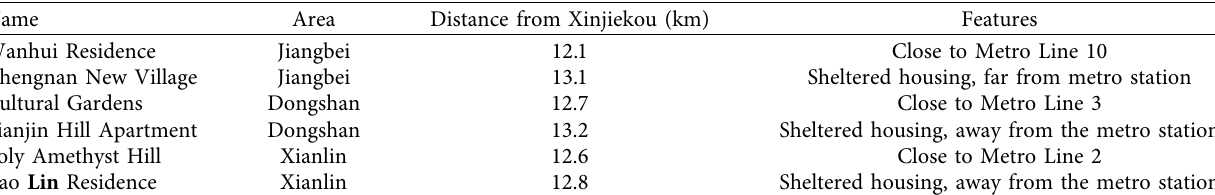
Figure 1: Location of the study area and the residential Table 1: Information on residential communities.